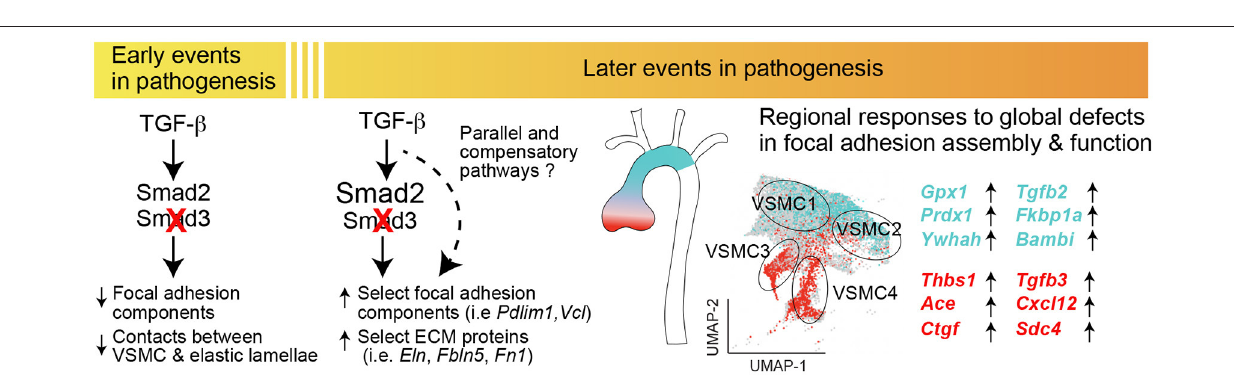
FIGURE 10 | Postnatal Smad3 inactivation in smooth muscle cells elicits a temporally and regionally distinct pathogenic response. Diagram summarizing the major findings of the study. Smad3 inactivation in VSMCs results in a broad reduction in the expression of components of the extracellular matrix and focal adhesions, including integrins and anchoring proteins, and results in loss of connections between VSMCs and elastic lamellae. Later in the disease process, normalization or upregulation of transcripts belonging to the same functional categories associates with upregulation of transcripts coding for putatively pro-pathogenic factors such as Ace , Thbs1 , Cxcl12 as well as that of TGF- β ligands; these changes are most pronounced in VSMC subsets enriched in the aortic root, while upregulation of putatively protective transcripts is more pronounced in VSMC subsets enriched in the ascending aorta, which is less prone to dilation in this model. These data suggest that loss of functional matrix and focal adhesions has secondary consequences specific to each VSMC subset, possibly contributing to the regional susceptibility to dilation in the